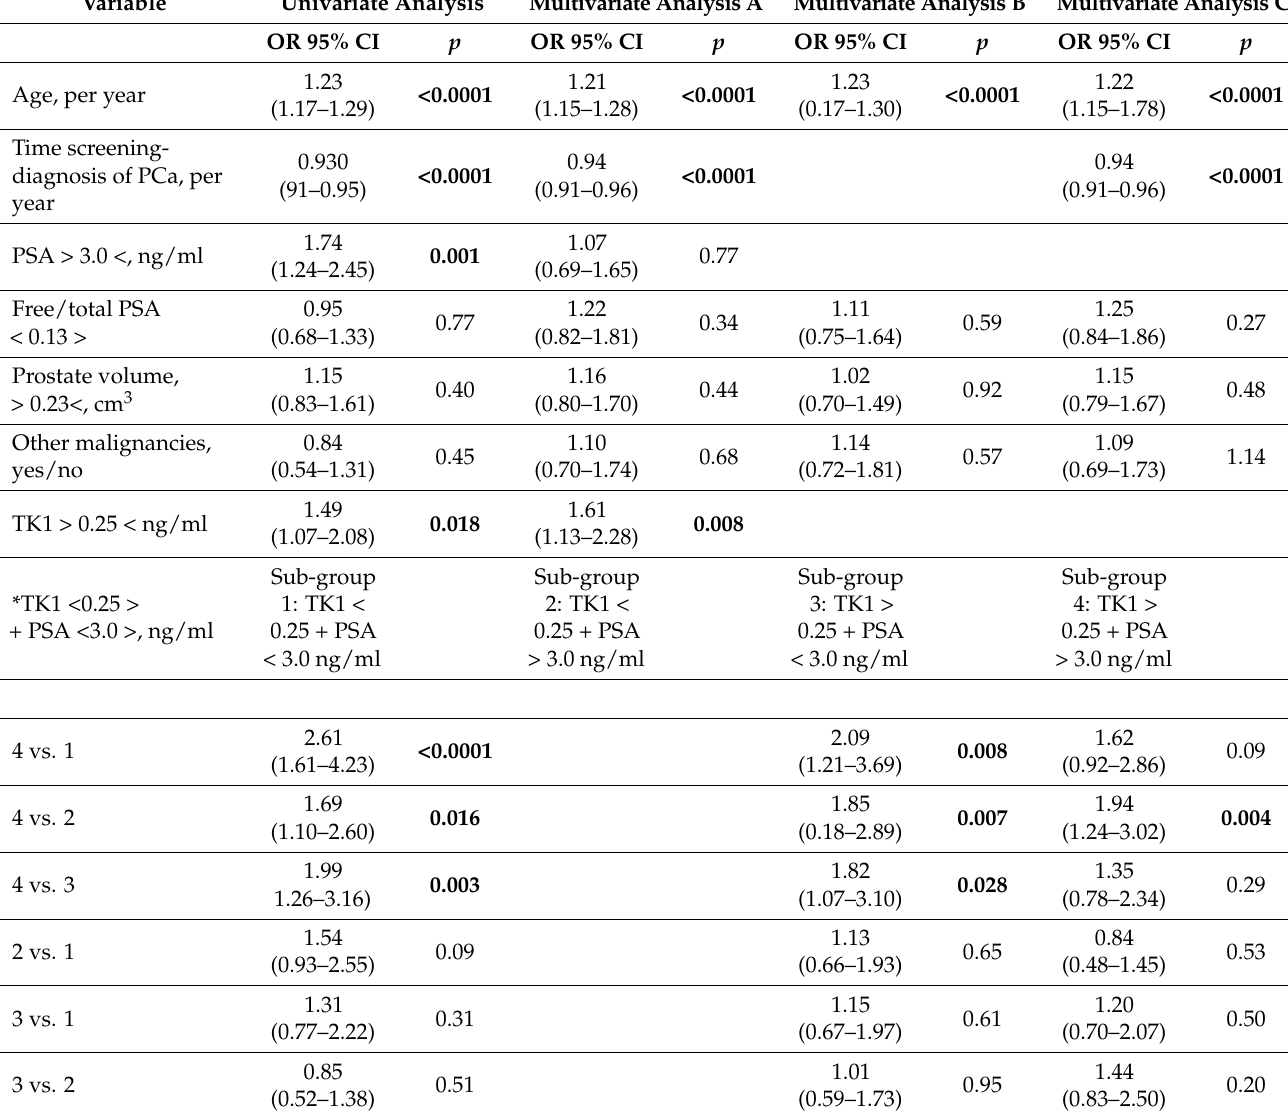
Table 3. Evaluation of baseline data by univariate and multivariate analyses for overall survival in 175 men with prostate cancer. *The biomarker TK1+PSA has 4